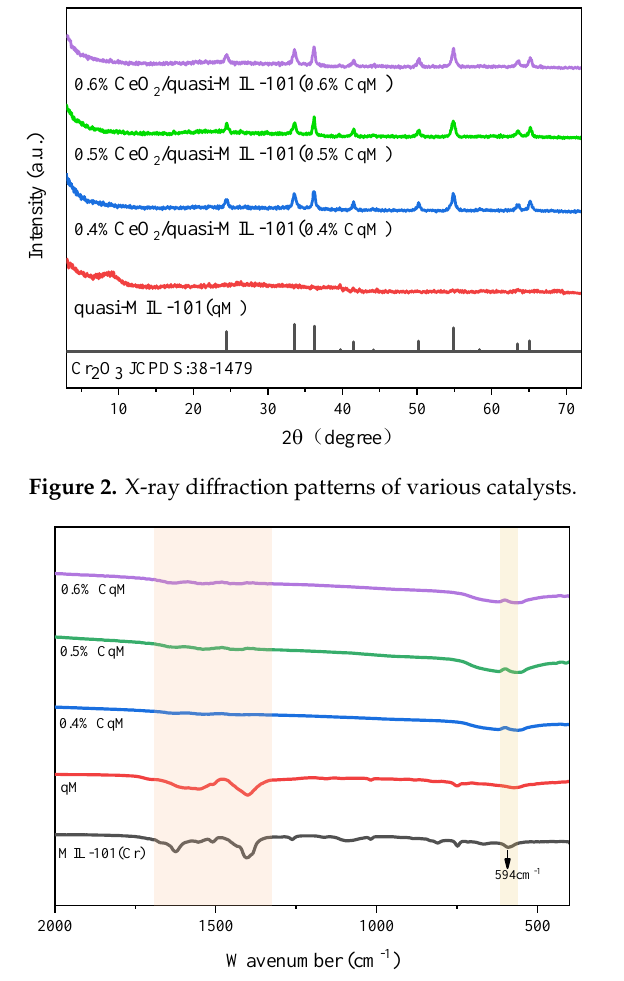
Figure 3. Fourier Transform infrared spectroscopy (FT-IR) characterization of various catalysts.